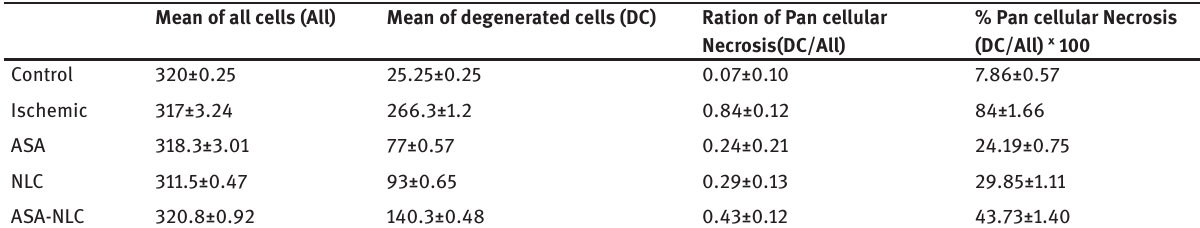
Table 2: Mean of all neurons (All), degenerative neural cells (Dc) and pancellular necrosis (Dc/All) in four fields from each section of the CA1